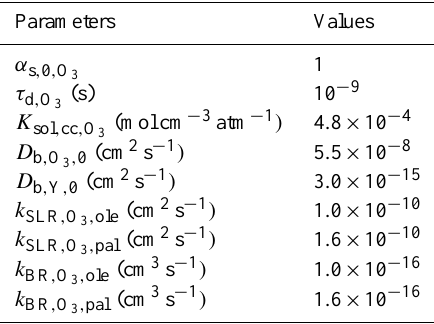
Table 1. Kinetic parameters for the interaction of ozone and multi- component organics (compare List of symbols in Appendix A).